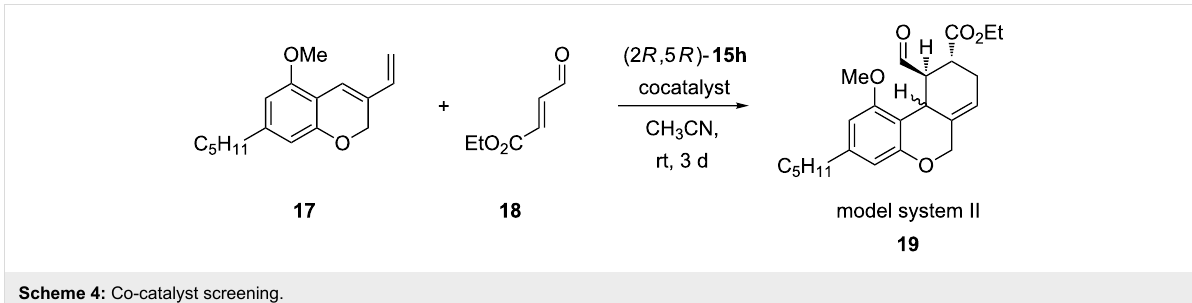
Scheme 4: Co-catalyst screening.